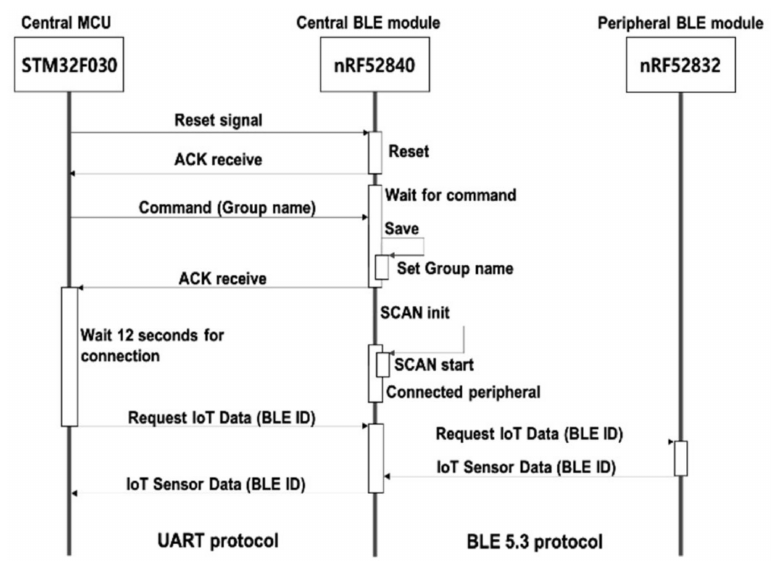
Figure 5. Sequence diagram of central